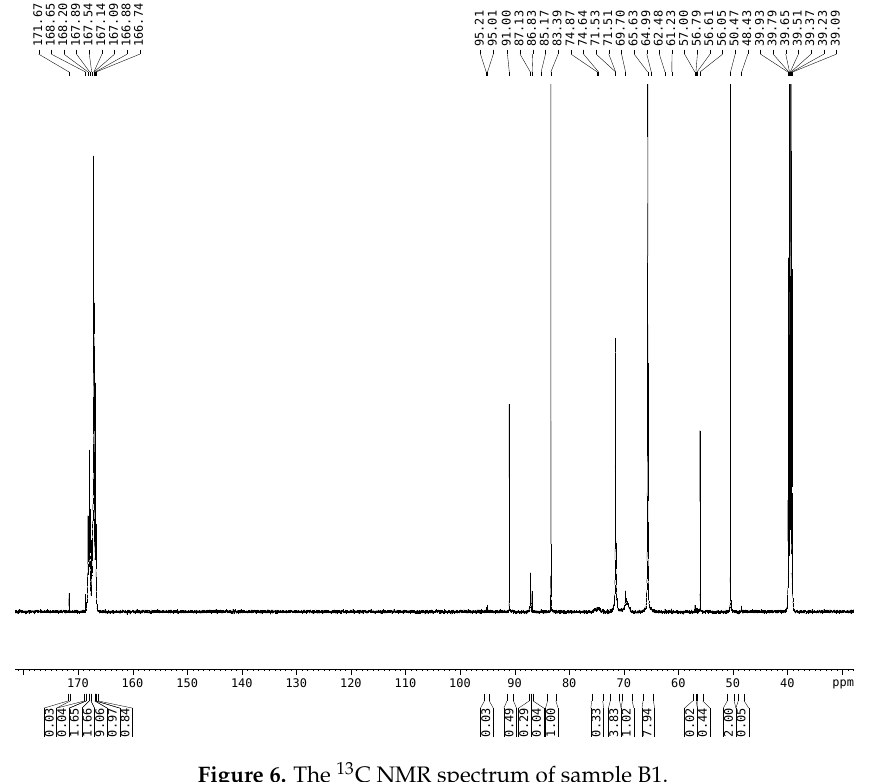
Figure 6. The 13 C NMR spectrum of sample B1.